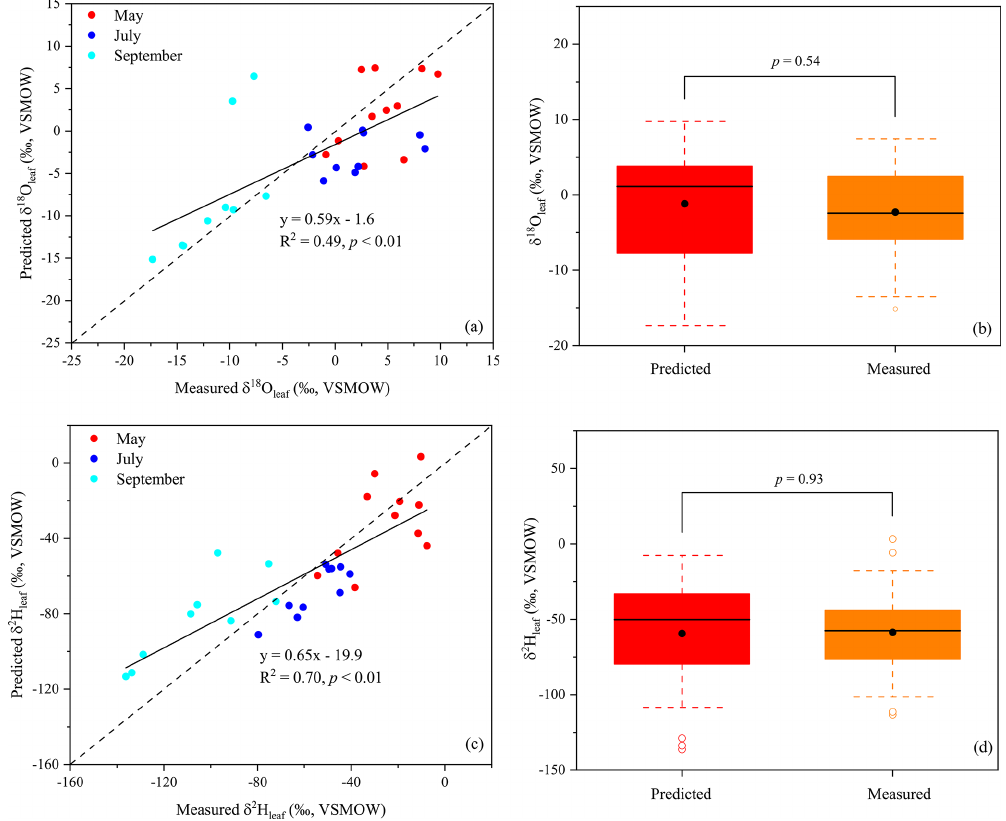
Figure 3. Measured leaf water isotopic composition for δ 18 O (a) and δ 2 H (c) values against values predicted by the C–G model. Boxplots show no significant differences for δ 18 O (b) and δ 2 H (d) values between measured and predicted leaf water. The dotted lines show one-to-one lines.